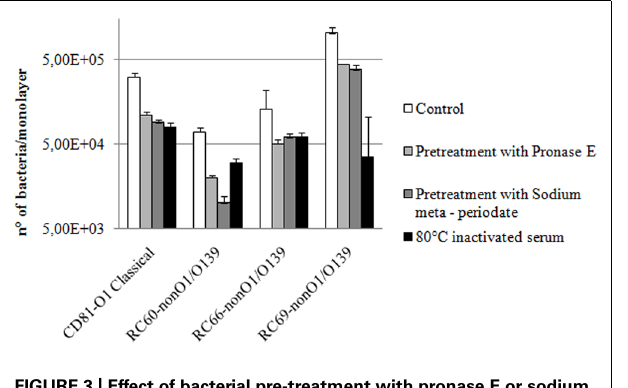
FIGURE 3 | Effect of bacterial pre-treatment with pronase E or sodium meta-periodate and serum heat inactivation on V. cholerae strains adhesion to hemocyte monolayers (4 ◦ C) in serum, after 60 min of incubation. P < 0.05.